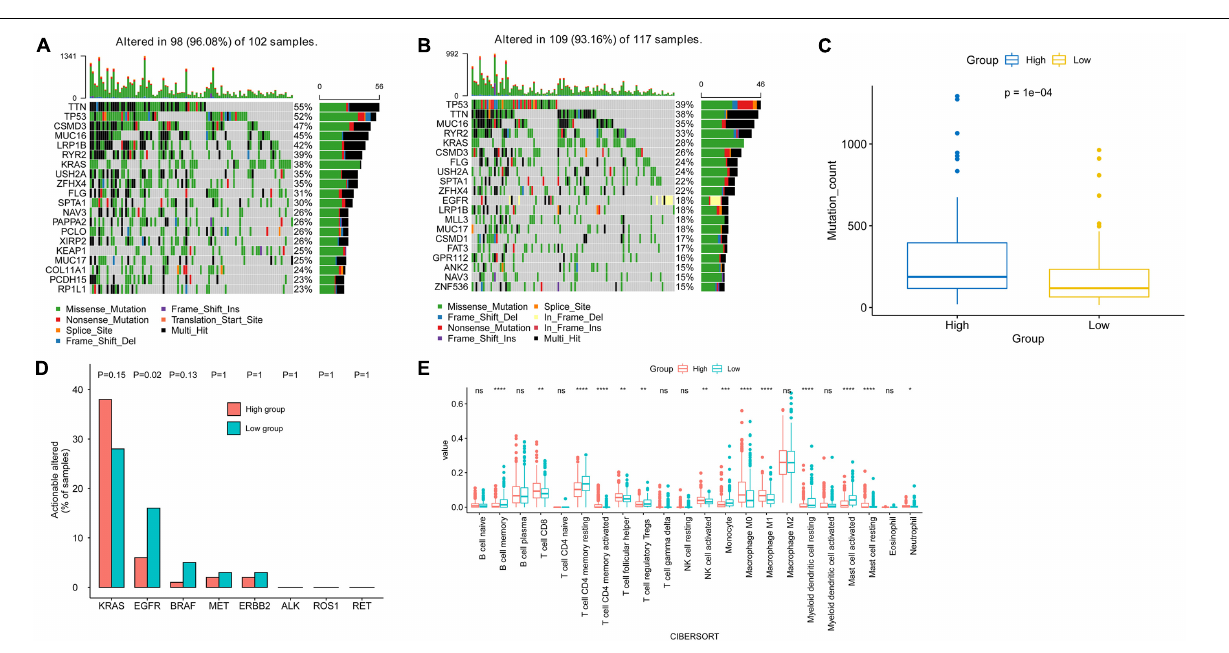
FIGURE 6 | Genomic mutations and tumor microenvironment analysis in the high-risk and low-risk subgroups. The top 20 most frequently mutated genes in high-risk (A) and low-risk (B) subgroups. (C) Comparison of mutation count between the two risk subgroups. (D) Comparison of the prevalence of actionable genes in LUAD between two risk subgroups. (E) Comparison of immune cell infiltration between two risk